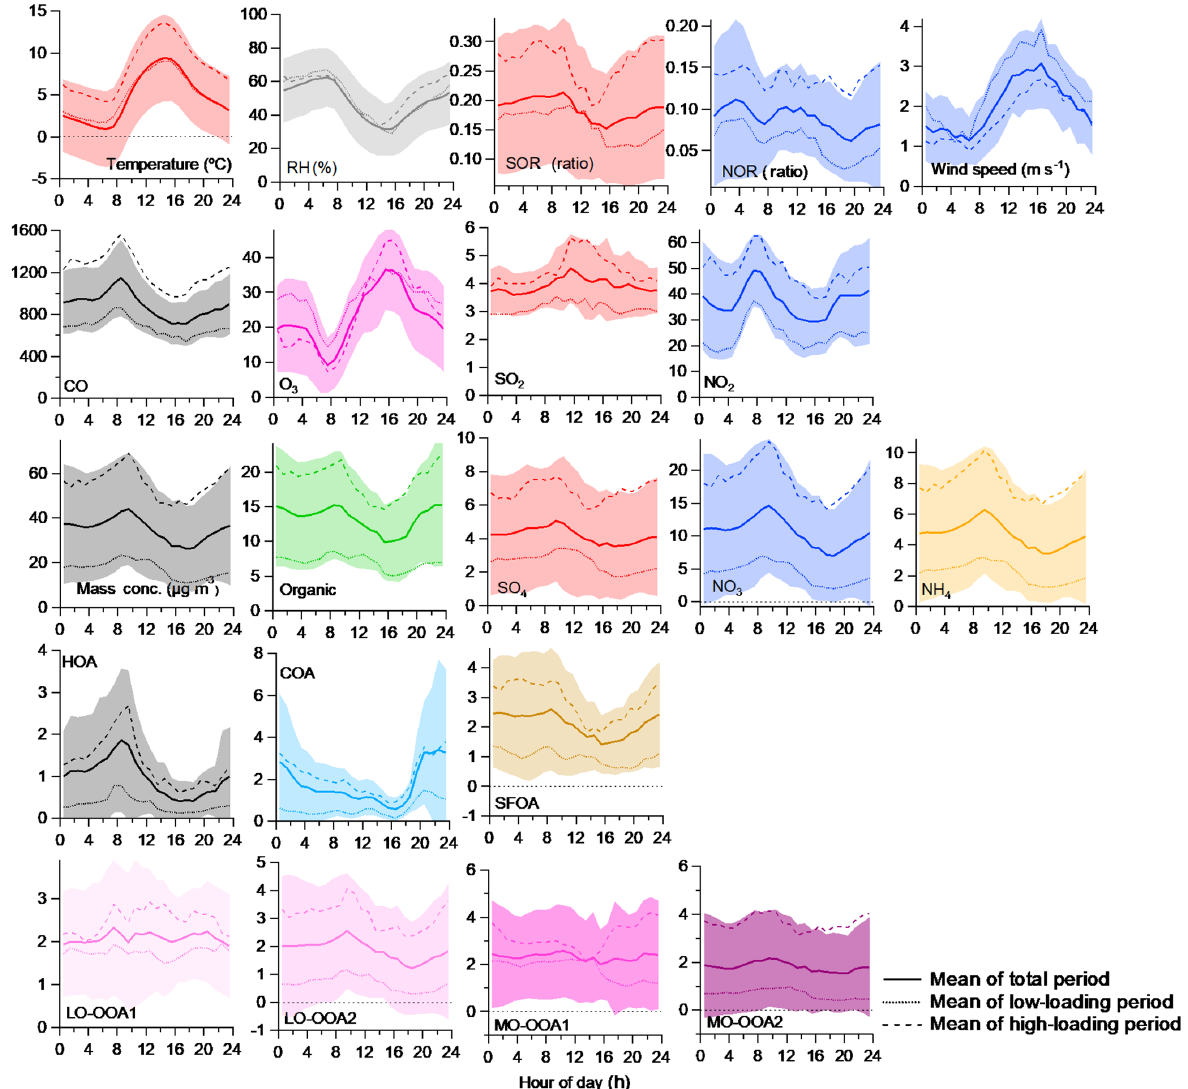
Figure 7. Comparison of the 1h averaged diurnal profiles for the various meteorological parameters (top row), gas-phase species (second row from the top), PM 1 species (third row), primary OA (fourth row), and secondary OA (fifth row) between the high- (haze) and low-loading (clean) periods. The solid line and shaded area indicate the mean ± SD. The dotted line indicates the low-loading (clean) period and the dashed line indicates the high-loading (haze)